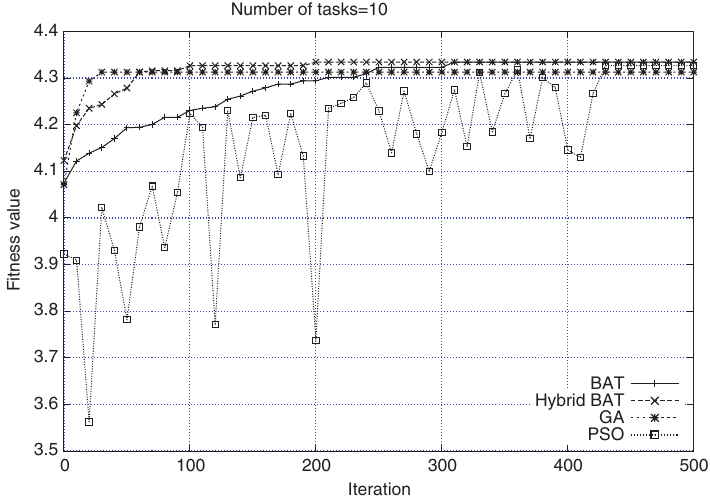
Figure 2: WS Composition – 10 tasks, 50 Candidate WSs.